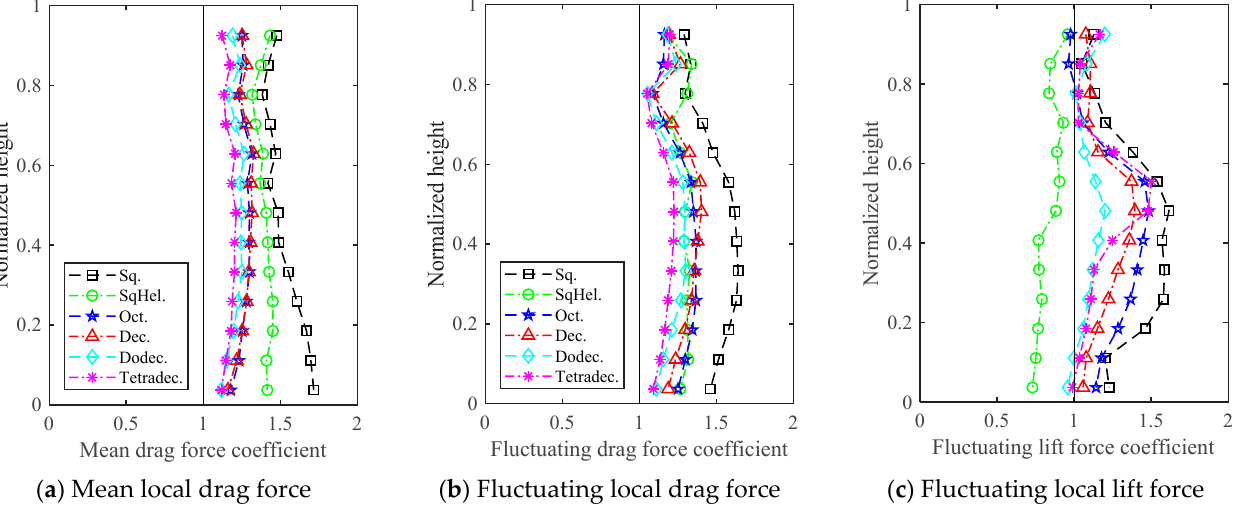
Figure 13. Maximum force coefficients for all cases (ratio to circular wind turbine).